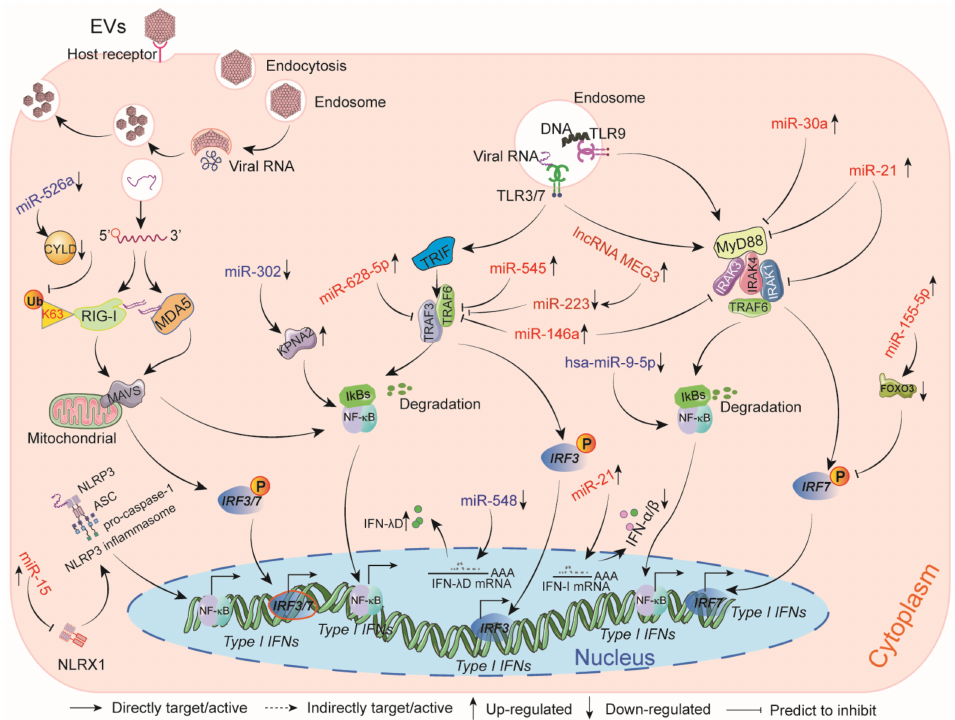
Figure 3. The impact of ncRNAs on host innate immune responses induced by EVs. Dysregulated ncRNAs suppress or promote host innate immune responses by either directly targeting type I type I interferon (IFN) genes or by indirectly targeting other molecules that influence these innate